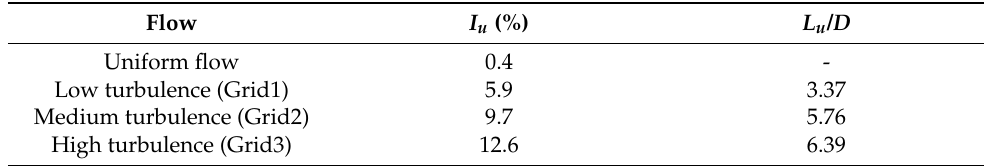
Table 2. Properties of turbulence flow.